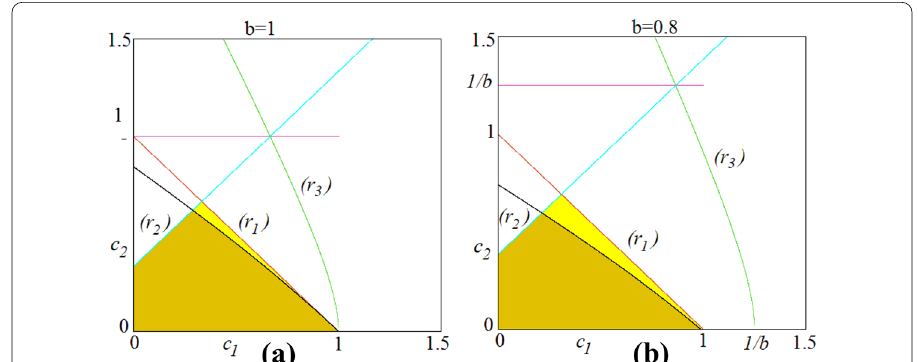
1 in the parameter plane ( c 1 , c 2 ) . In a at ≤ 0 given in (40). In the orange =